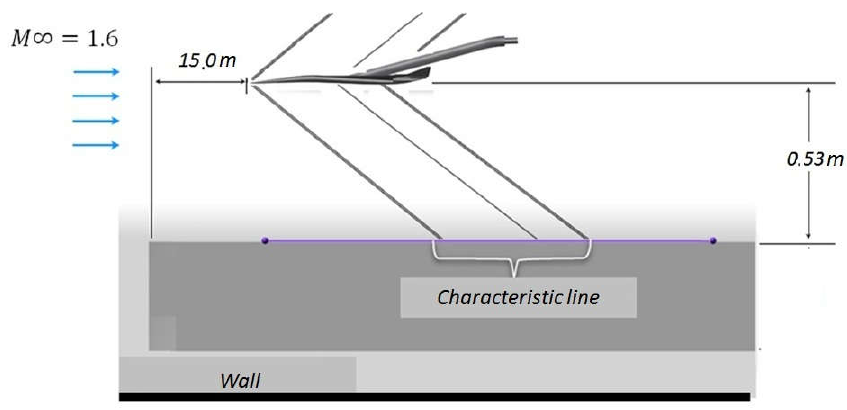
Figure 19. The experiment layout (LM1021).